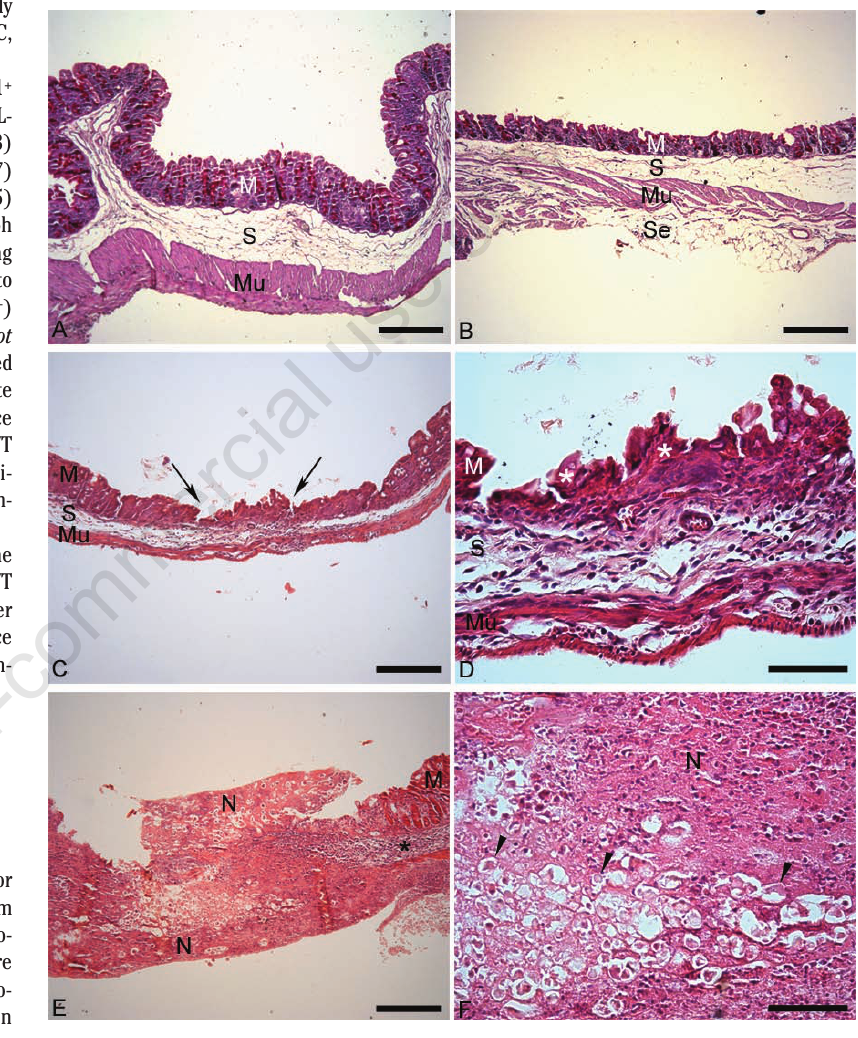
Figure 3A. Cell suspensions from caecal lymph nodes were analyzed by flow cytometry using antibodies to CD3 and to NK1.1 molecules to distinguish between NK cells (CD3 – NK1.1 + )